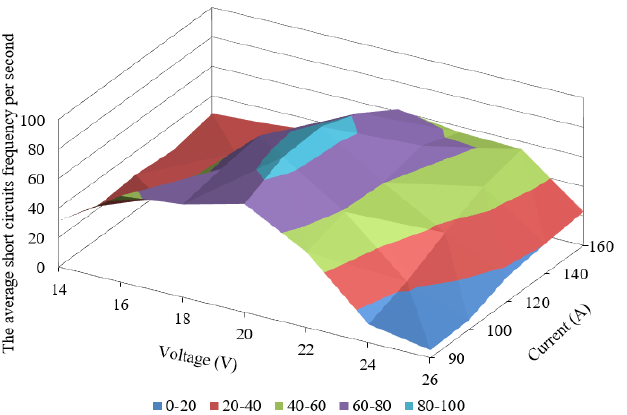
Figure 6. Graph of the dependence of the average short circuit frequency per second on current and voltage at the constant tool travel speed.